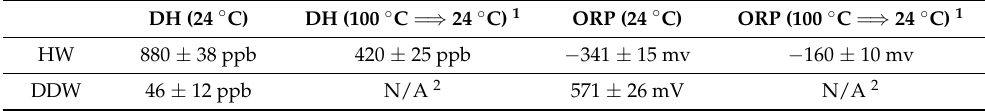
Table 1. The characteristics of HW and DDW.